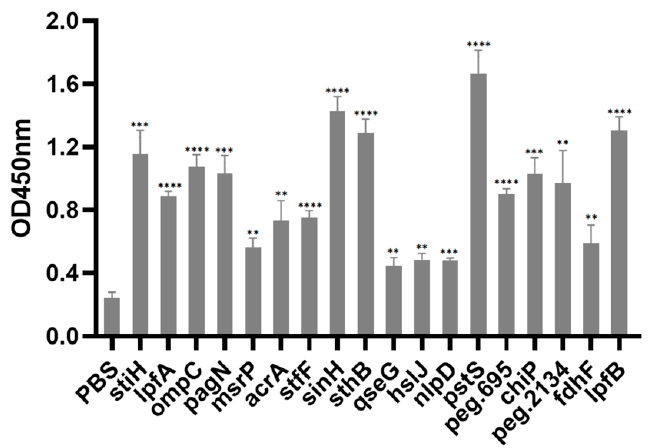
Figure 4. ELISA analysis of sera collected on day 14 post-immunization (day 11 post-hatching). The antisera from chicks mock-vaccinated with PBS were set as a negative control (NC). Statistical analysis was compared to the NC group. p < 0.01 (**), p < 0.001 (***), or p < 0.0001 (****). Table 4. Inter- and intra-assay variabilities of candidate proteins.